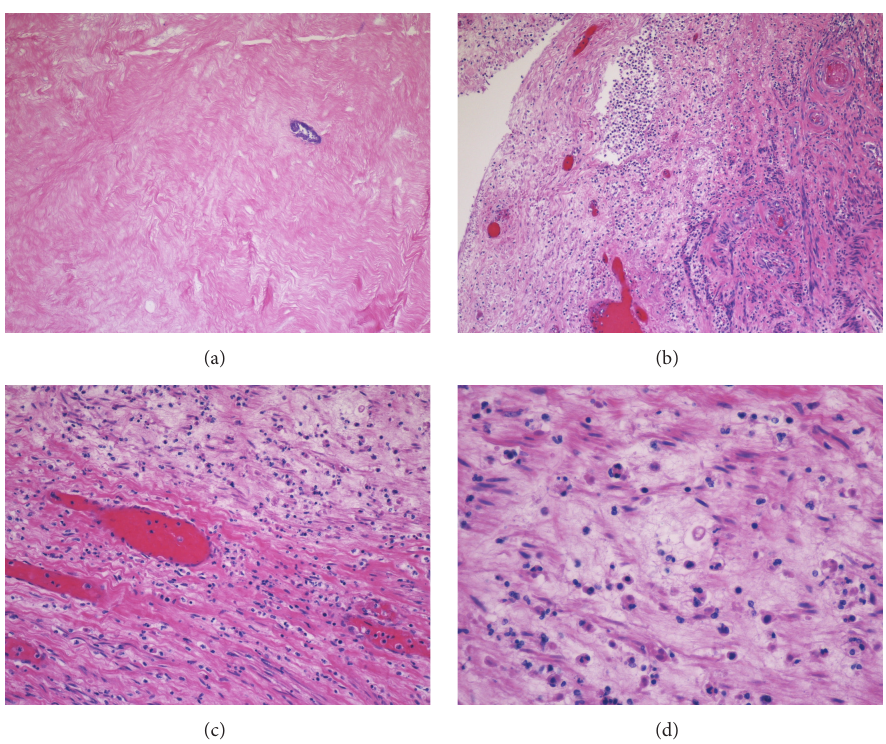
Figure 3: Hematoxylin and Eosin histologic appearance of the degenerating leiomyoma: (a) complete loss of nuclei from the cells on 10x magnification, (b, c) diffuse infiltrate of polymorphous neutrophils at 10x and 20x, respectively, and (d) stromal